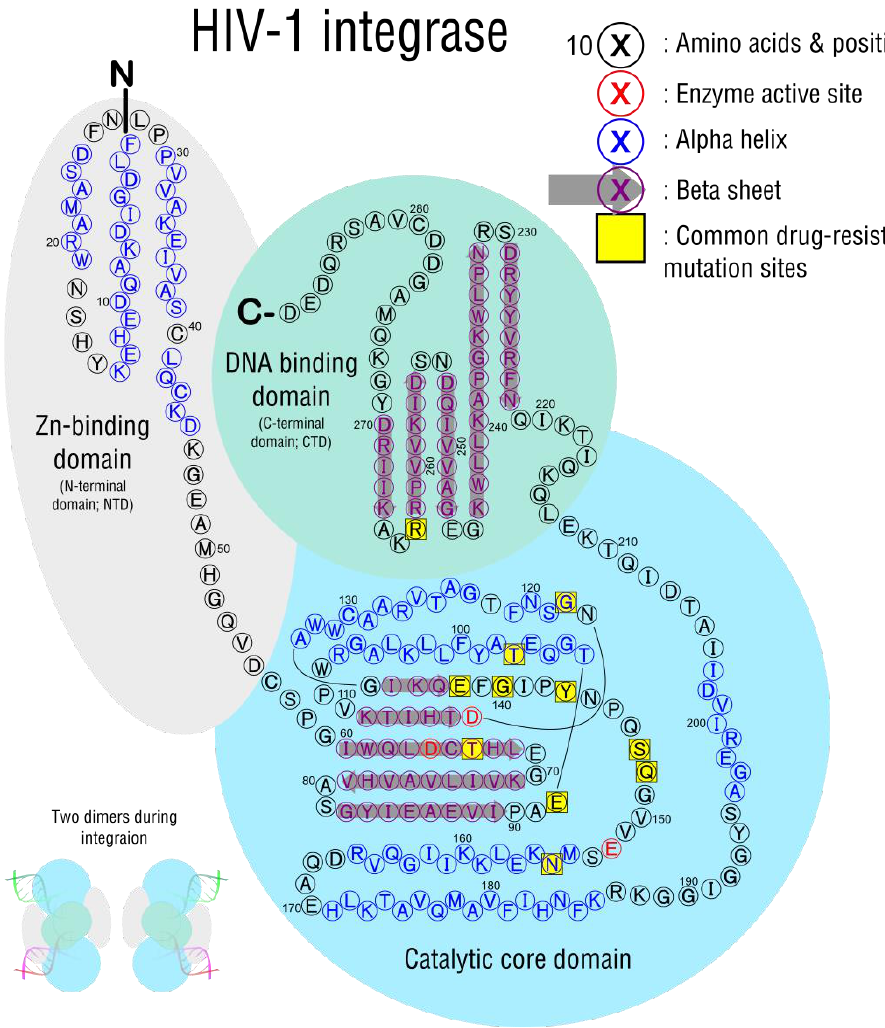
Figure 9. HIV integrase structure, two-dimensional monomer map. Two dimers of this protein bind either end of the HIV genome during integration. The active site is considered to be the essential Asp64, Asp116, and Glu152 (the D,D-35-E motif) [101]. His12, His16, Cys40, and Cys43 bind Zn 2+ [102]. The sequence of each domain from PDB files 1WJA [103], 1IHV [101], and 1BIS [104]. Multimer structure based on [105]. In the multimer image (lower left), the red DNA (host) and green DNA (virus) represent that these strands will be recombined.